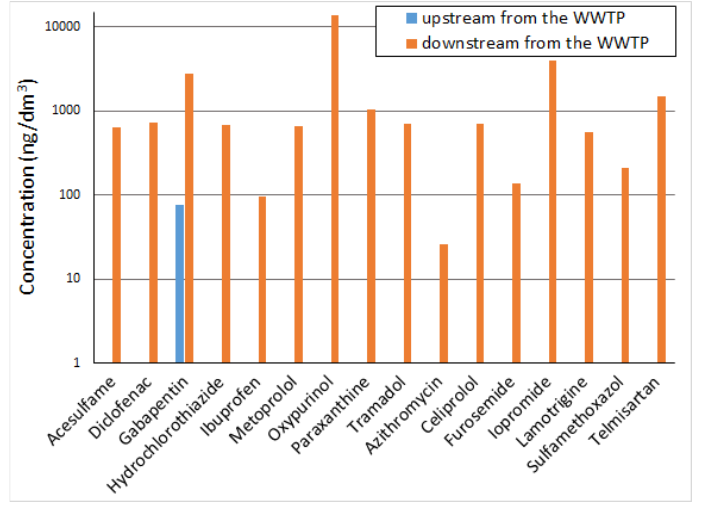
Figure 10. Concentration of 16 selected pharmaceuticals in the profiles upstream and downstream from the Hnevkovice WWTP on 28 June 2019 (only substances detected above the detection limit).